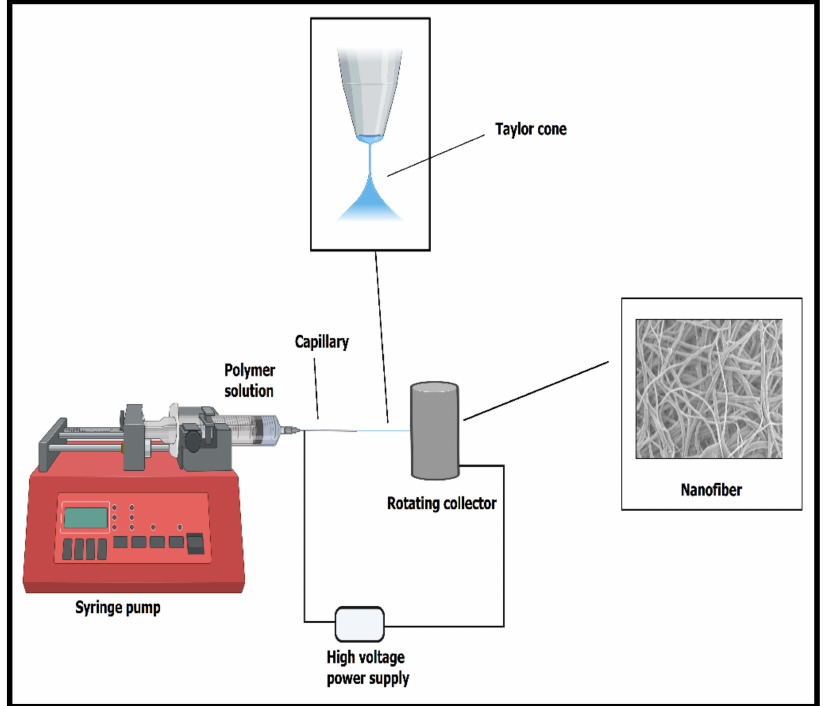
Figure 2. Simple representation of the formation of the Taylor cone and the electrospinning setup to form nanofibers using a high-voltage power